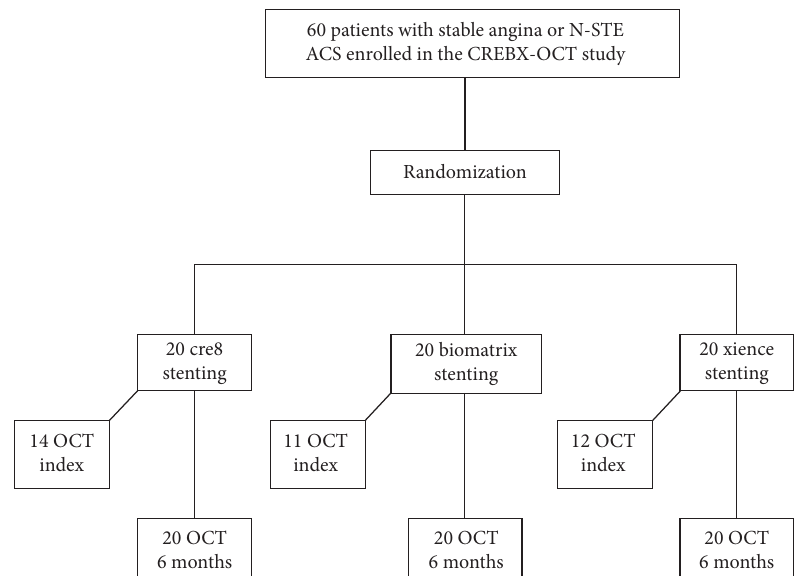
Figure 1: Study’s flow chart. PCI: percutaneous coronary intervention; N-STE ACS: non-ST segment elevation acute coronary syndrome; OCT: optical coherence